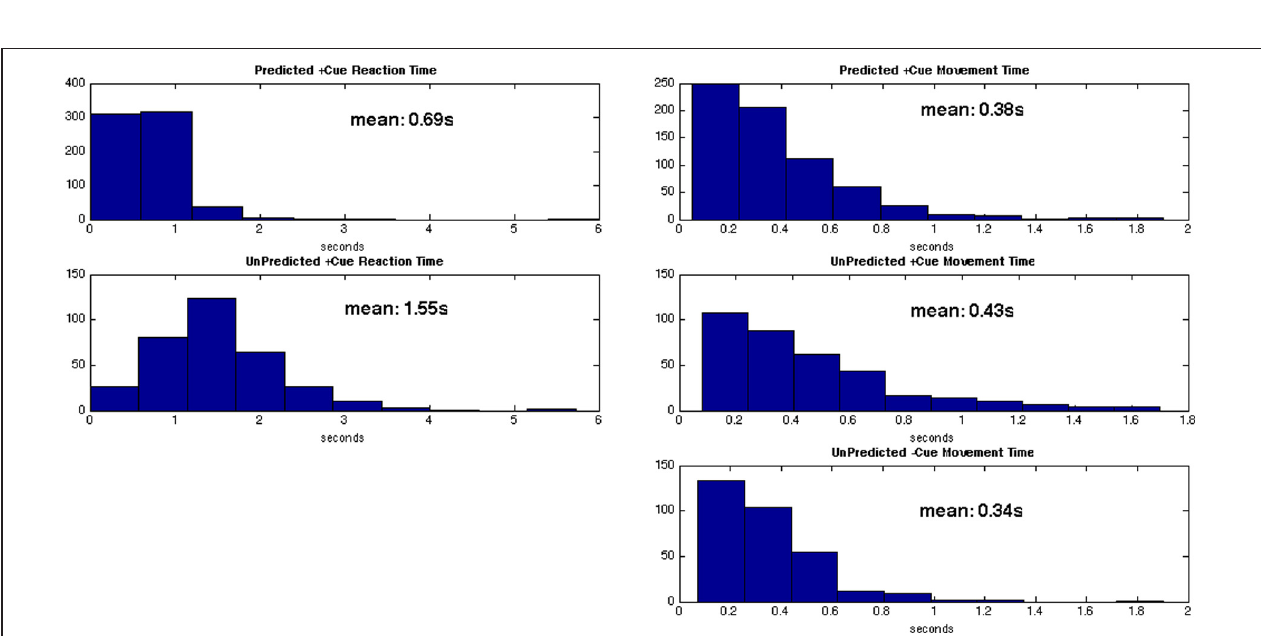
FIGURE 6 | Distributions for reaction times (left) and movement times (right) for each trial type.